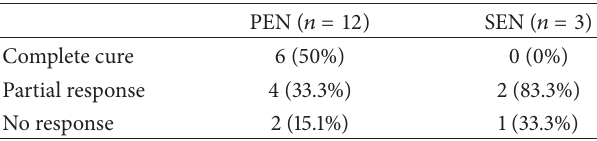
Table 2: The improvement rates after surgery in PEN and SEN